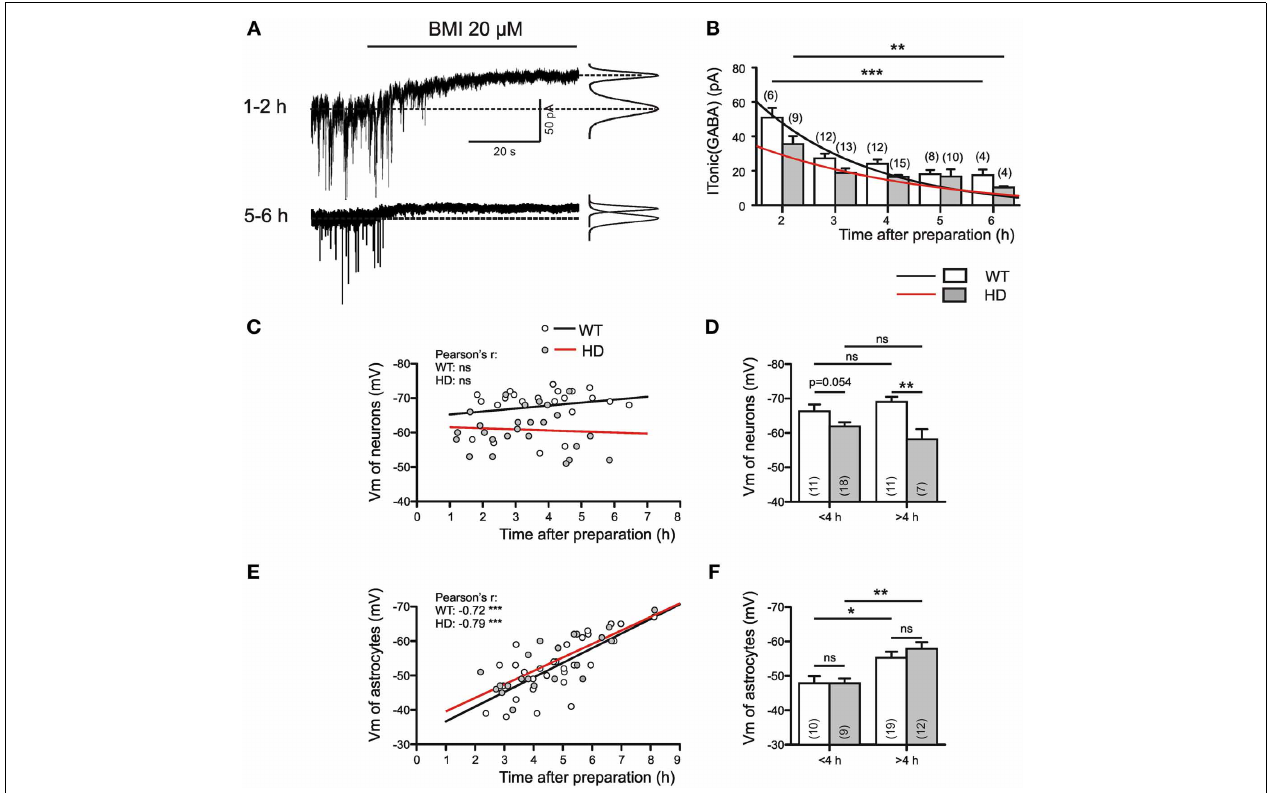
FIGURE 3 | I Tonic ( GABA ) in WT and Q175 HOMs at different times after slice preparation. (A) Sample traces from 2 different WT SONs from the Q175 colony; age: 55 weeks. Experiment in the presence of DNQX (10 µ M), APV (50 µ M), LY341495 (40 µ M); no K channel block; V h = − 70mV, E Cl = 4mV. On the right: Gaussian fits to all-points histograms derived from 30s recording periods under control conditions and in the presence of BMI. The difference between the peaks of the fitting curves represents the amplitude of I Tonic ( GABA ) as plotted in (B) . (B) Average values of I Tonic ( GABA ) obtained from WT (empty bars) and Q175 HD (filled bars) at variable time after preparation. The differences